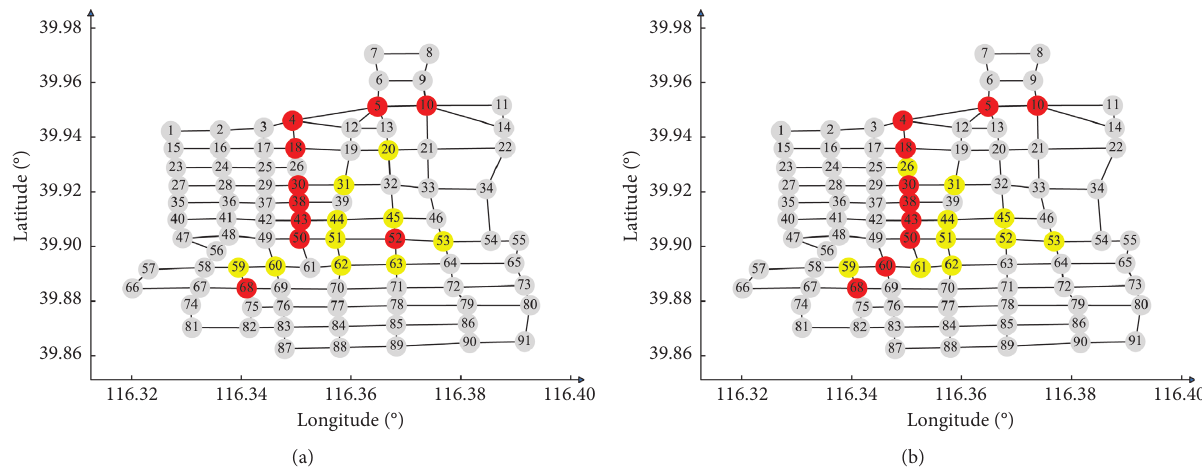
Figure 12: Identification results of key nodes in peak hours on Monday. (a) 7:00–9:00. (b)